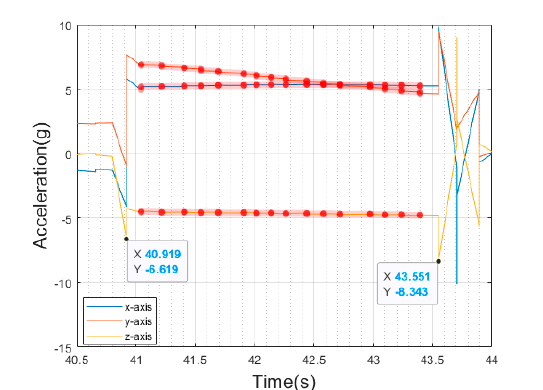
Figure 5. Flight time measurements of a spinning ball.